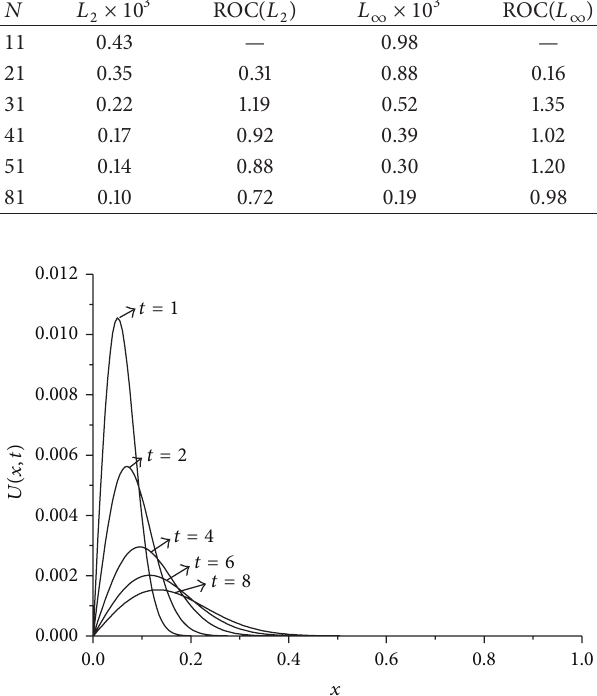
Figure 2: Solution behavior of the equation with ℎ = 0, 005 , 𝑡 = 0, 01 , and V = 0.001 .